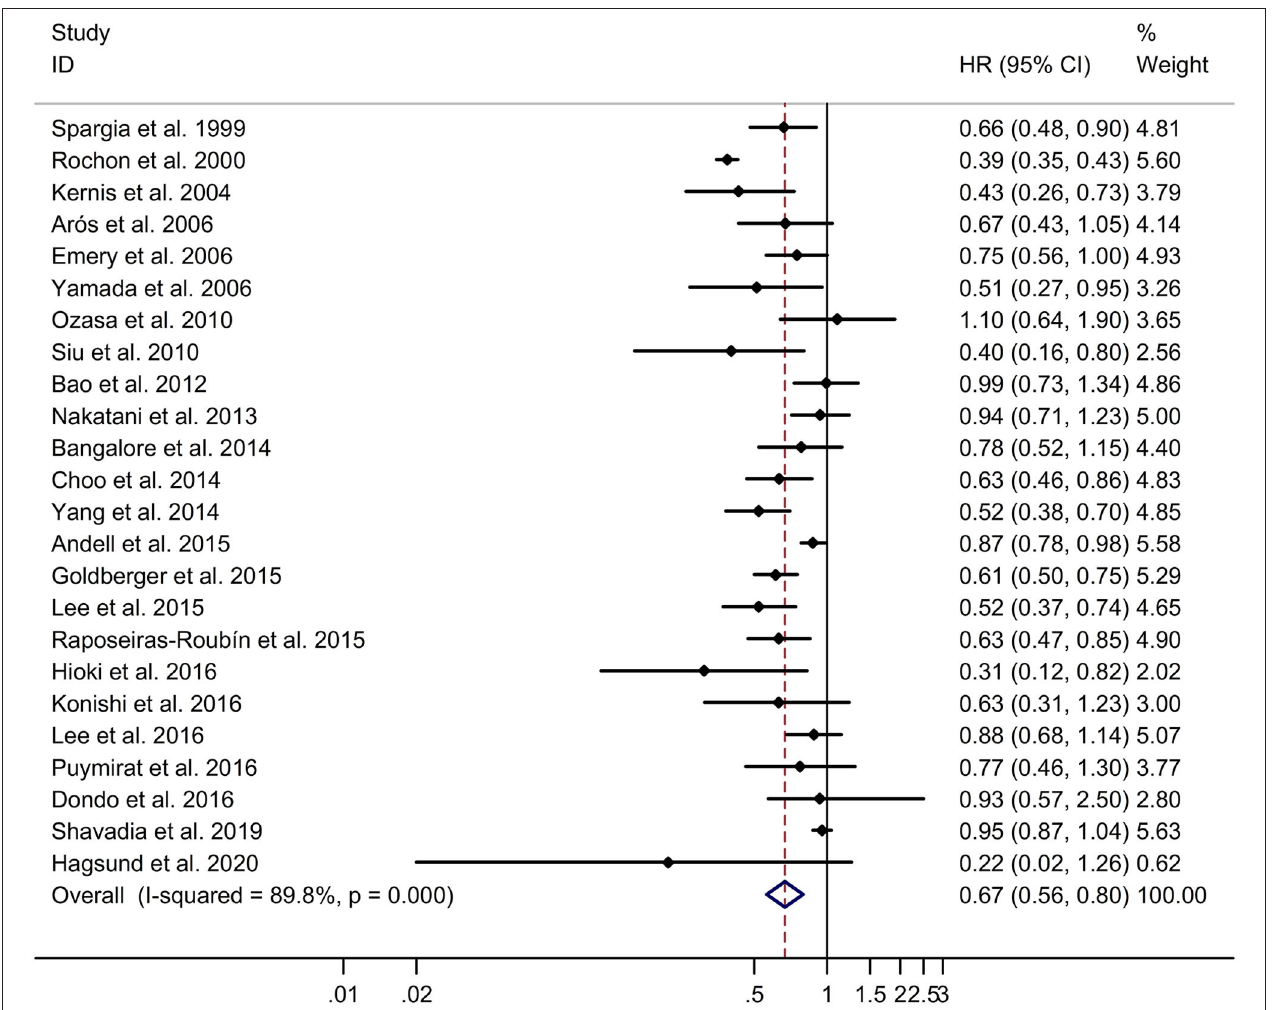
FIGURE 1 | Forest plots exploring the long-term effect of β -blocker use on all-cause mortality in patients after MI. CIs, confidence intervals; HRs, hazard ratios; MI, myocardial infarction.